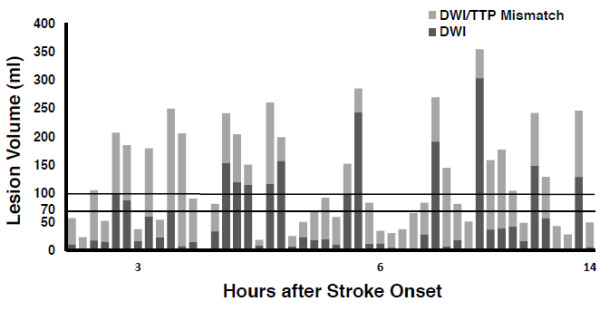
DWI and mismatch volumes of entire prospective cohort in order of time after stroke onset. Abnormal DWI volume of each patient is depicted as a dark gray bar. Light gray bars represent the DWI/TTP mismatch. Horizontal lines delineate volumes of 70 ml and 100 ml. All patients with DWI lesion volume of 70 ml or less had at least 100% mismatch volume. There was no significant correlation between time from stroke onset and DWI lesion volume or between time and mismatch volume. DWI: Diffusion weighted imaging; TTP: Time to peak.